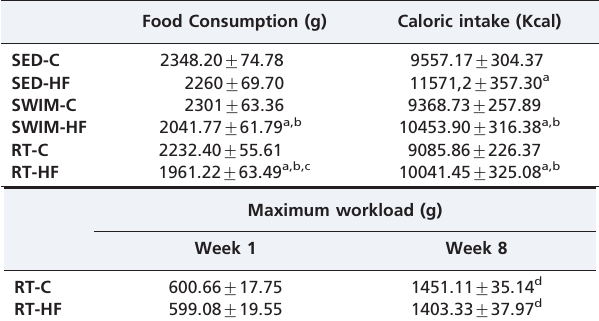
Table 1 - The effects of exercise and diet on food consumption, caloric intake and maximum workload during the experiment period.